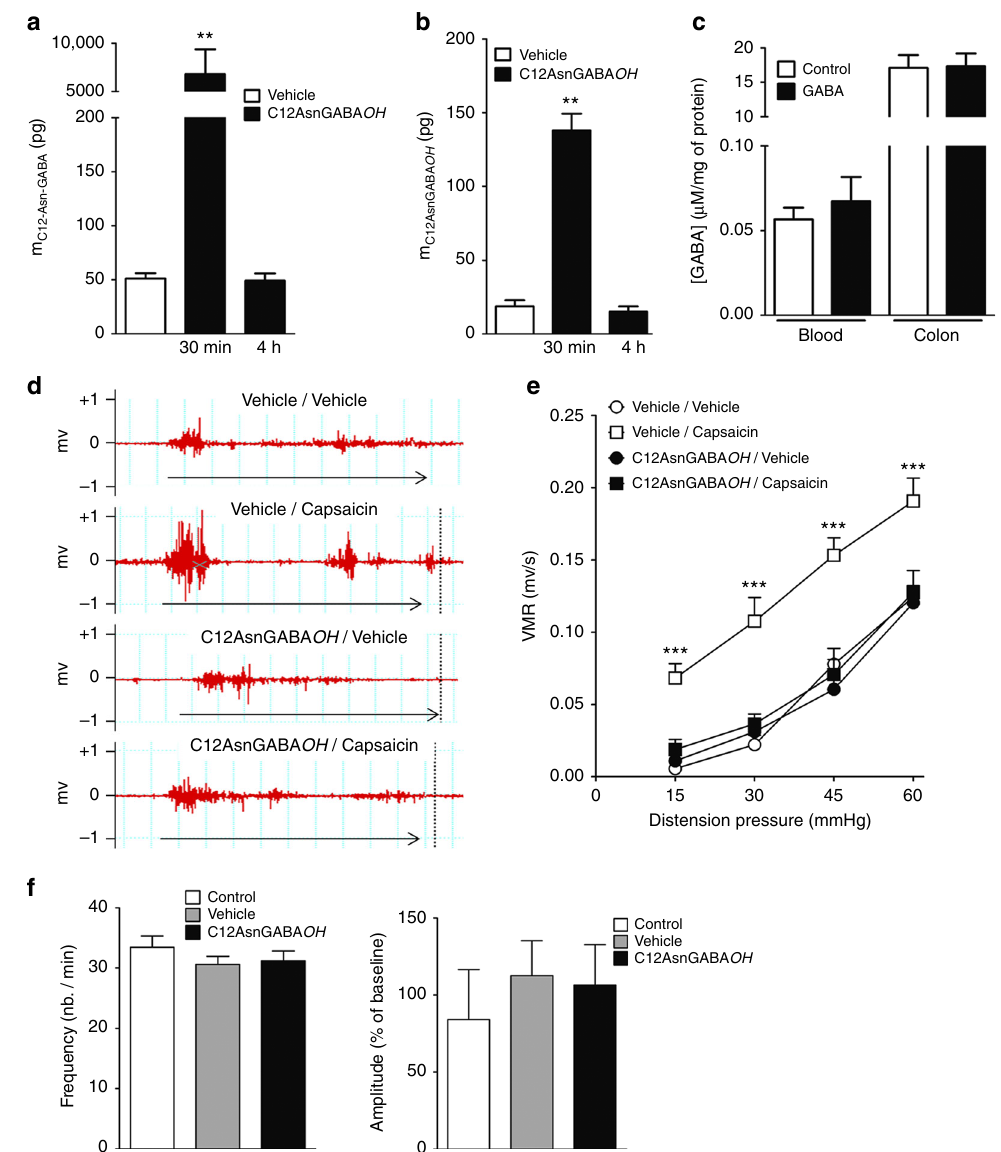
Fig. 7 C12AsnGABA inhibits capsaicin-induced VH without altering intestinal contraction. Mice received intracolonic administration of C12AsnGABA OH (10 µ M; black bars) or vehicle (40% ethanol; white bars) and 30 min or 4 h later colon ( a ) and blood ( b ) were harvested in order to quantify C12AsnGABA OH by LC-MS/MS. Data are expressed as mean ± SEM, n = 8 mice per group. Statistical analysis was performed using Kruskal – Wallis analysis of variance and subsequent Dunn ’ s post hoc test. *** p < 0.001 signi fi cantly different from vehicle group. c Mice received